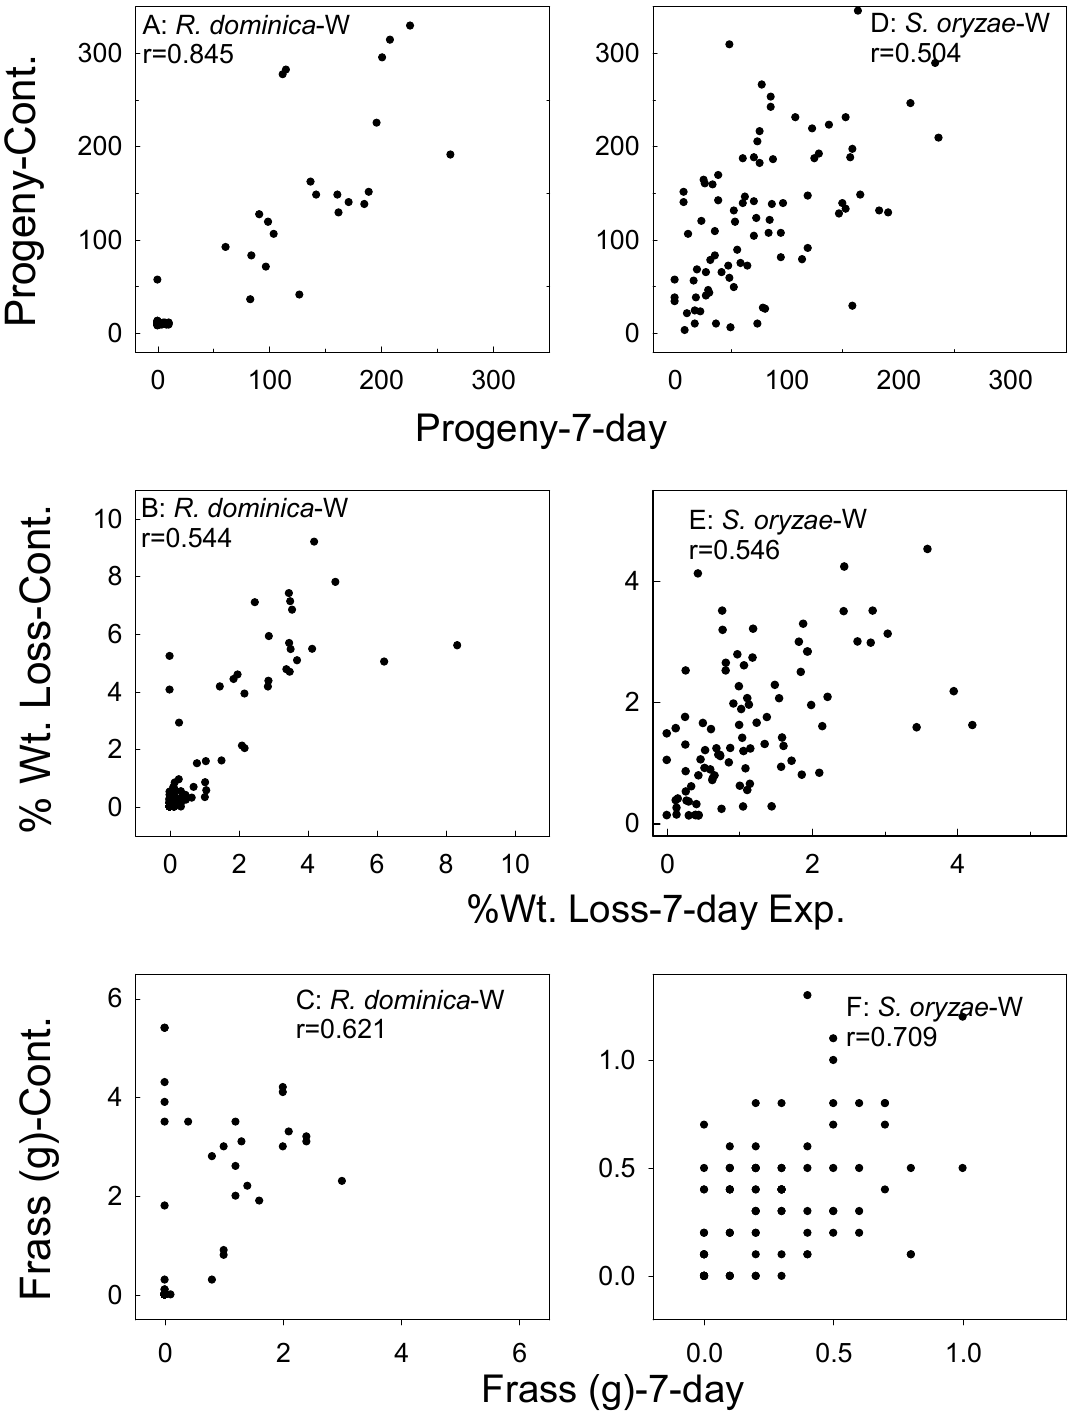
Figure 2. Correlation of F 1 progeny, sample weight loss, and feeding damage (frass weight) in the wheat (W) samples whereby parental adults were exposed for 7 days versus the continual exposures of parental adults for R. dominica ( A–C ) and S. oryzae ( D–F ). Data combined for all treatments and all bioassay months.